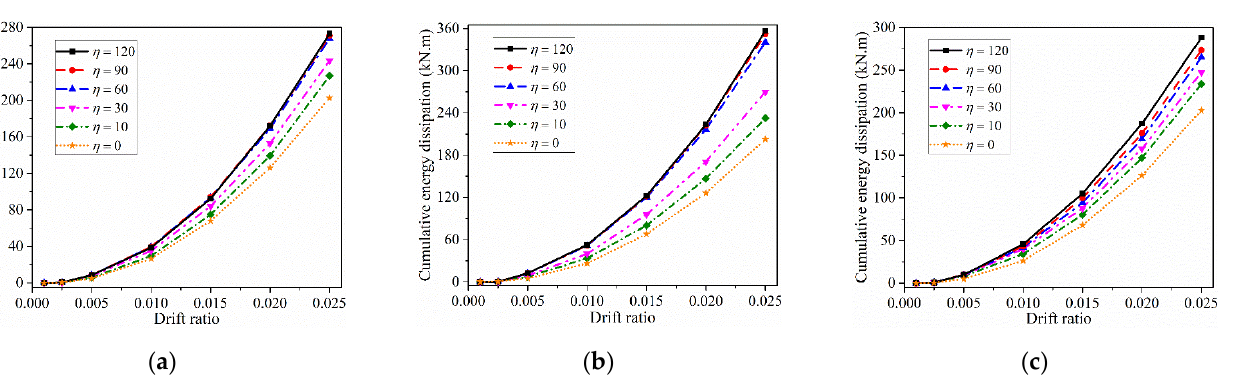
Figure 15. Cumulative energy dissipations of: ( a ) SPSW1 − 1VHS, ( b ) SPSW1 − 3VHS, and ( c ) Figure 15. SPSW1 − DS with different η .